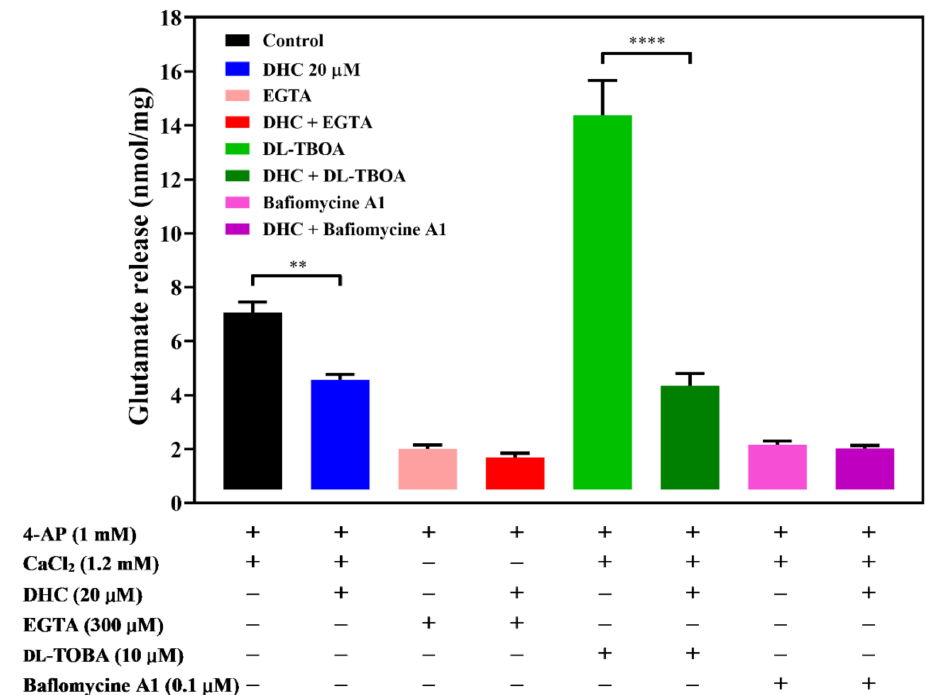
Figure 2. Effect of the Ca 2+ chelator EGTA, glutamate transporter inhibitor DL -TBOA, or vacuolar ATPase inhibitor bafilomycin A1 on the action of DHC. Quantitative comparison of the extent of glutamate release by 1 mM 4-AP in the absence and presence of DHC. EGTA (300 µ M), DL -TBOA (10 µ M), bafilomycin A1 (0.1 µ M) and DHC (20 µ M) were added 10 min before depolarization. The results are the mean ± SEM values of independent experiments ( n = 5). ** p < 0.01 versus the control group, **** p < 0.0001 versus the DL -TBOA-treated